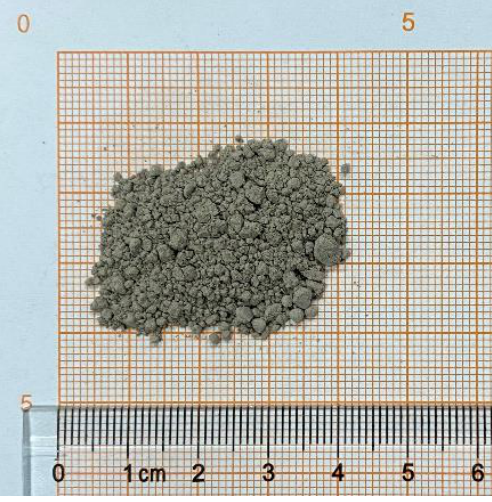
Figure 4. Fly ash sample.